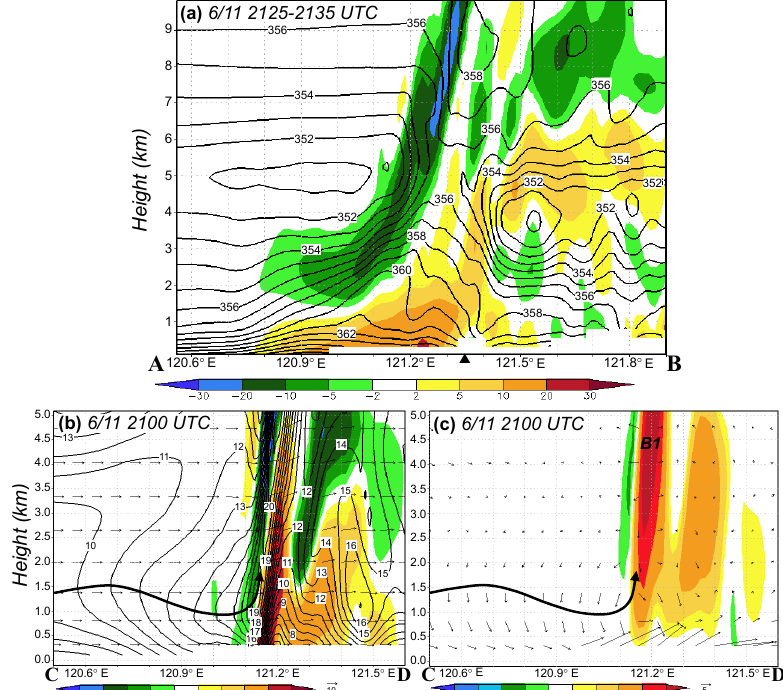
Figure 11. (a) E–W vertical cross section of model-simulated convergence/divergence (10 − 4 s − 1 , color, positive for convergence) and θ e (K, contour, every 1K) along 25 ◦ N (line AB in Fig. 10), averaged over 21:25–21:35UTC on 11 June 2012. The triangle marks the mean location of the updraft of B1. (b, c) As in panel (a) , except showing (b) convergence/divergence (color) and wind vectors (ms − 1 ) and speed (isotach every 1ms − 1 ) and (c) w (ms − 1 , color) and vertical wind shear vector (10 − 3 s − 1 , in cardinal direction, reference vectors both plotted) along the WSW–ENE section (line CD in Fig. 10) at 21:00UTC on 11 June 2012. Thick arrow-lines in panels (b, c) depict the axis of the LLJ.